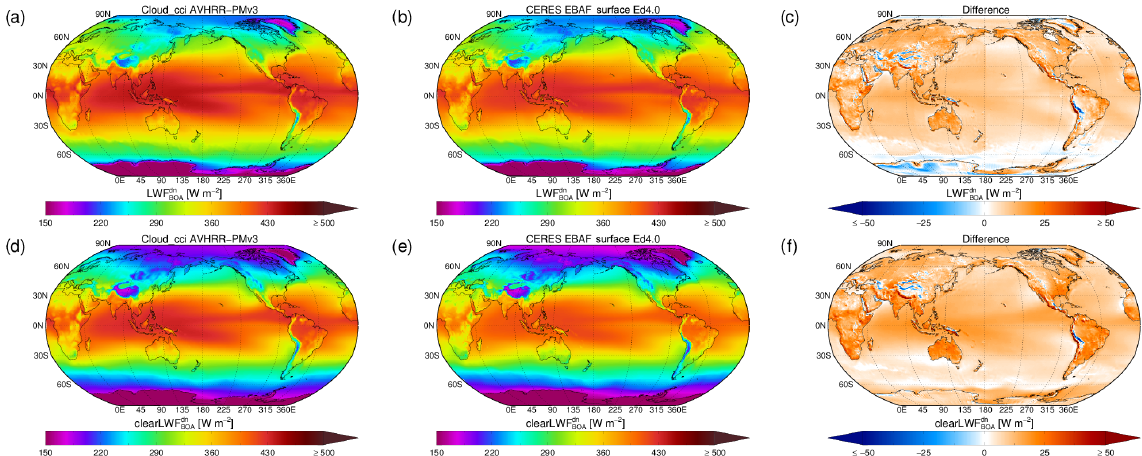
Figure 7. Multi-annual (2003–2016) mean downwelling longwave (LW) radiative fluxes at bottom of atmosphere (BOA) for all-sky con- ditions for Cloud_cci AVHRR-PMv3 (a) and CERES EBAF surface fluxes (b) . Panels (d) and (e) show the same data but for clear-sky conditions. Panels (c) and (f) show difference plots Cloud_cci minus